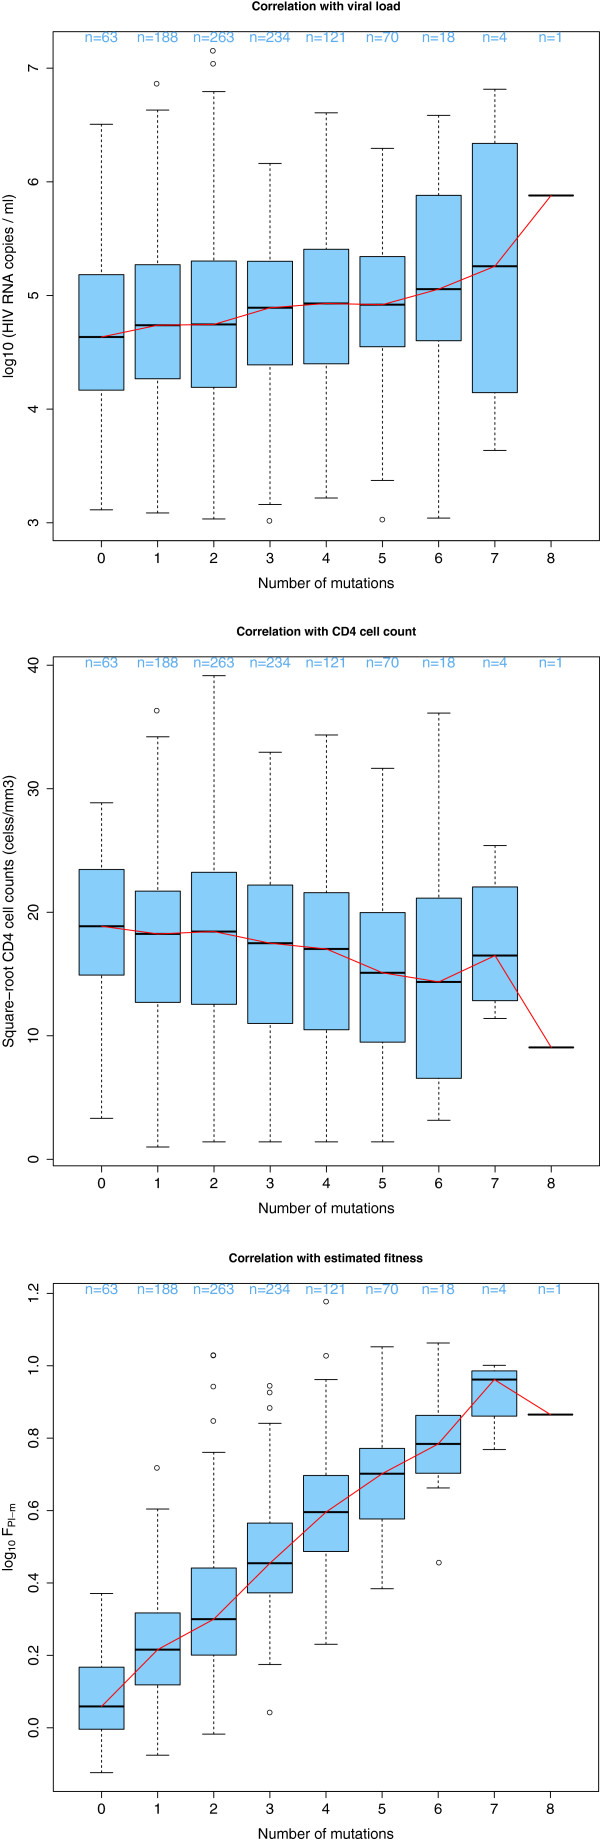
Association between the number of compensatory mutations, estimated fitness and clinical parameters. Compensatory mutations, polymorphic in subtype B protease and modeled by the fitness model FPI, are likely candidates to explain the observed association of viral fitness estimated under drug selective pressure with clinical parameters. For patients with no indications of acute infection and TDR (n = 962), the number of compensatory mutations (13V, 36I, 60E, 62V, 63P, 71V, 71T, 77I or 93L) in the protease sequence is calculated for each patient
[21]. The following parameters are grouped by mutation count: log10 viral RNA copies/ml (1a), square-root transformed CD4 cell counts (1b) and increased estimated fitness for protease log10FPI−m(1c). The distribution of the respective parameter is shown for each group using boxplots. The horizontal line (bold) within the boxplot represents the median value, with box boundaries indicating the interquartile range. Upper and lower ends of striped lines denote the most extreme data point which is no more than 1.5 times the IQR range from the box. An increased mutation number significantly correlated with 1a) increased log10 viral RNA copies/ml (p-value < 0.01), 1b) decreased square-root transformed CD4 cell counts (p-value < 0.01) and 1c) increased estimated fitness for protease log10FPI−m(p-value < 0.01). A fitted line going through the median values (lowess smooth) is shown in red. The number of patients for each group is shown above each bin.